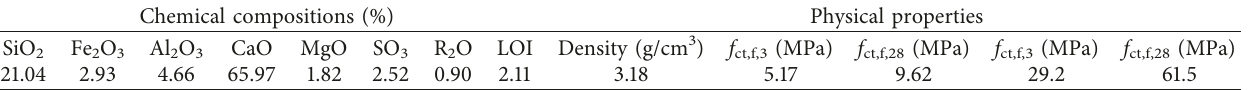
Table 3: The chemical compositions and physical properties and of the cement.